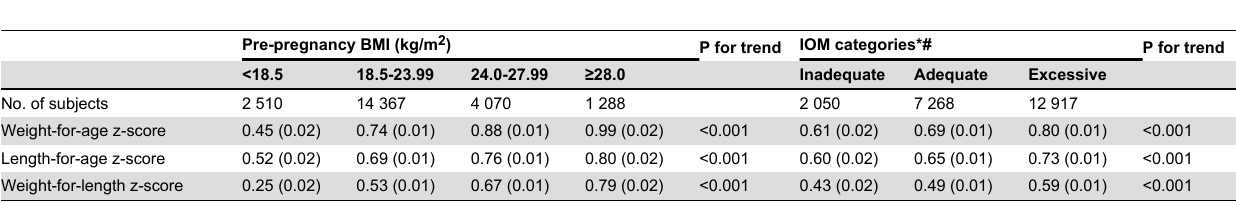
Table 2. Comparison of Z scores for body weight, body length, and weight for length during the first year of life by the repeated